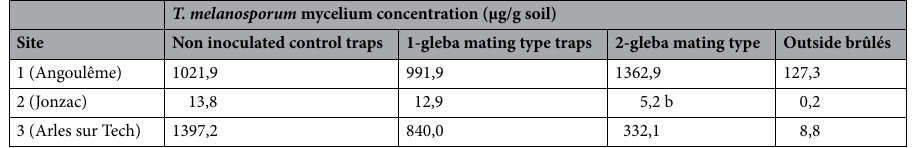
Table 1. Mean concentrations of T. melanosporum mycelium in truffle traps and in soil out of brûlés at the three study sites.